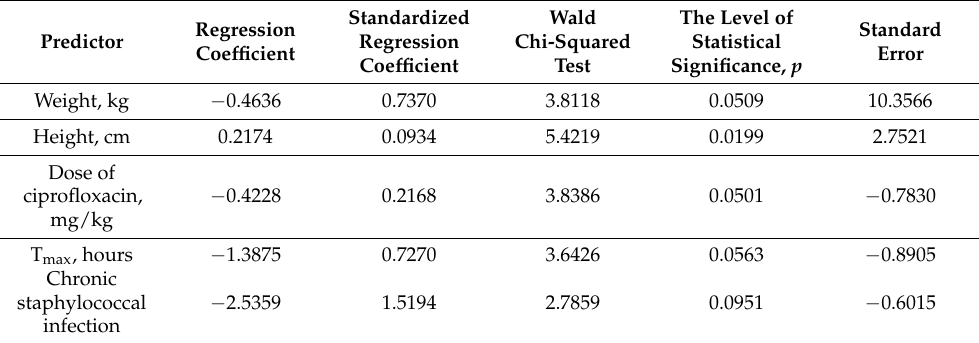
Table 16. Estimated logistic regression parameters with exclusion of CPF concentration in patients with different genotype variants of GCLC